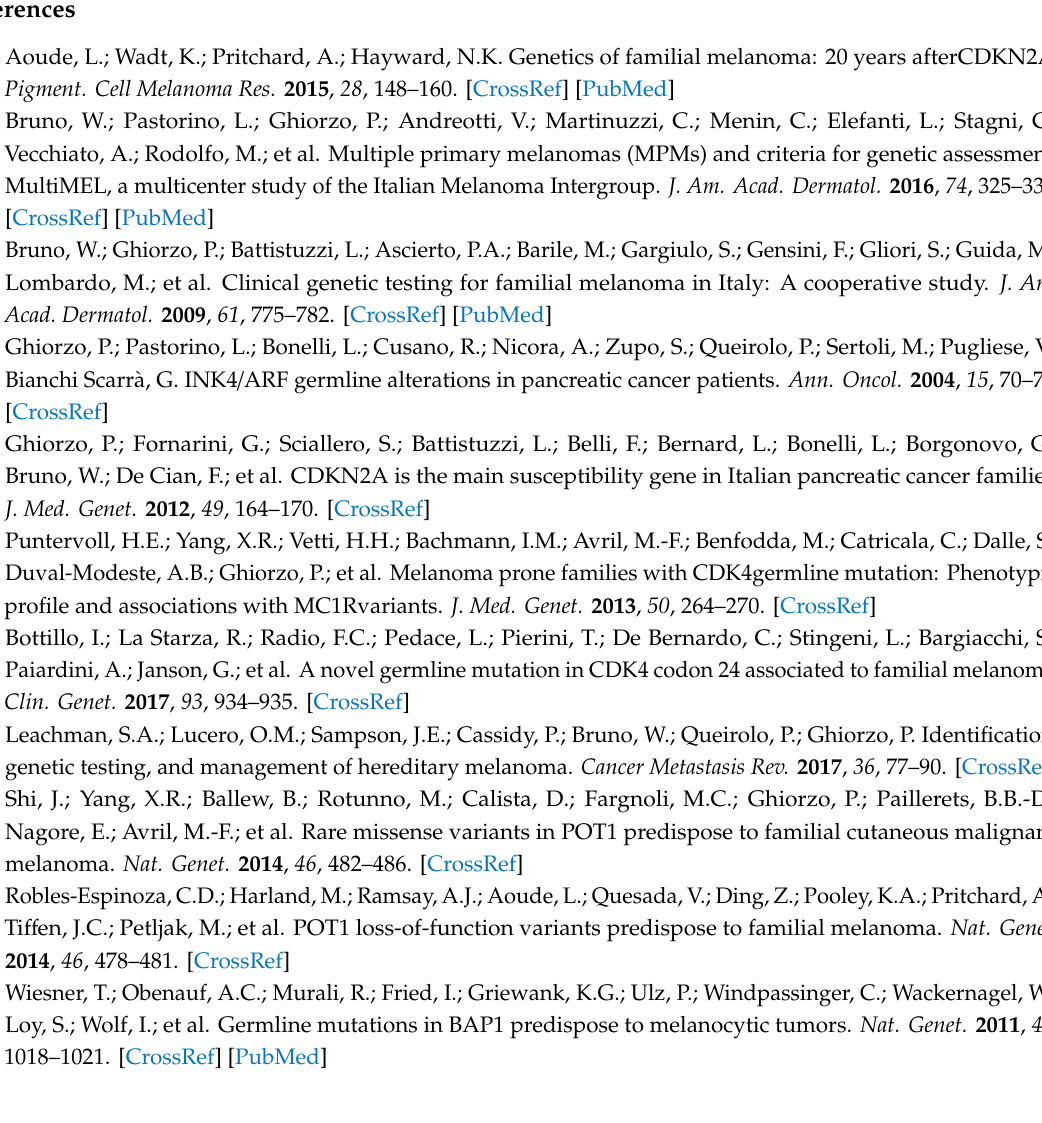
Figure S1: Pedigree diagrams from the families carrying loss of function variants in BAP1 , POT1 , ATM , ACD genes; Figure S2: Pedigree diagram from the family with the rare c.799_800delCA BAP1 germline